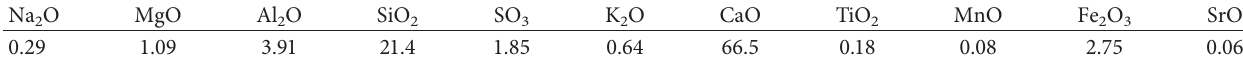
Table 1: Chemical compositions of cement (in mass